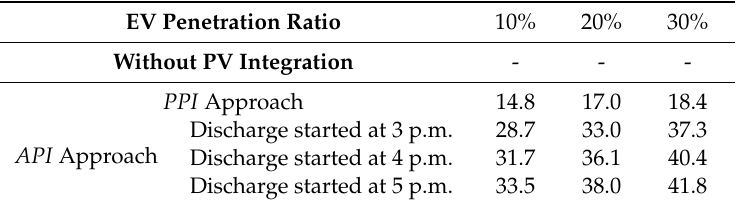
Table 2. Decrease rate of DT LOL (%) for the cases of Table